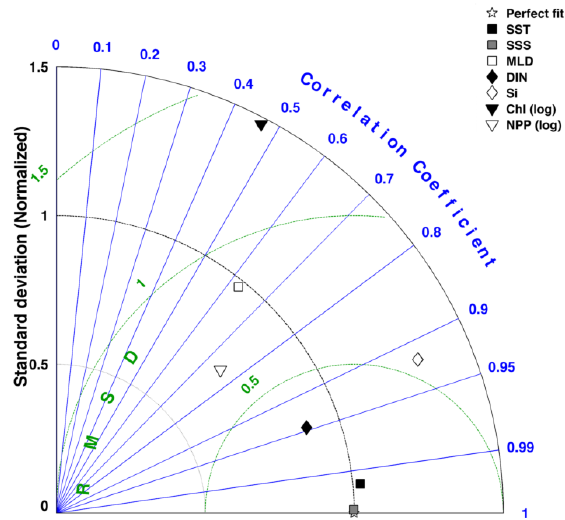
Figure 15. Taylor diagram for the Southern Ocean south of 50 ◦ S showing correlation, normalized SD and the normalized root mean square error between the spatial distribution of the model results and observed data sets, weighted by area. All values are surface values, except the mixed layer depth and the vertically integrated NPP. The fields have been linearly interpolated to a 1 ◦ × 1 ◦ grid, similar to the World Ocean Atlas. he model SD and root mean square error have been normalized by the observational